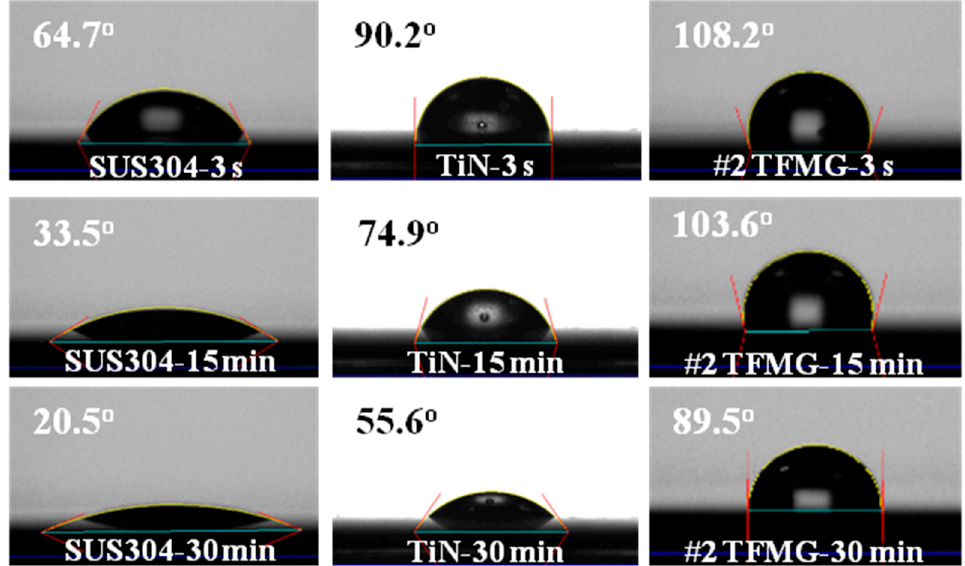
Figure 7. Images of water contact angles on SUS304, TiN, and Zr-Cu-Ti TFMG.